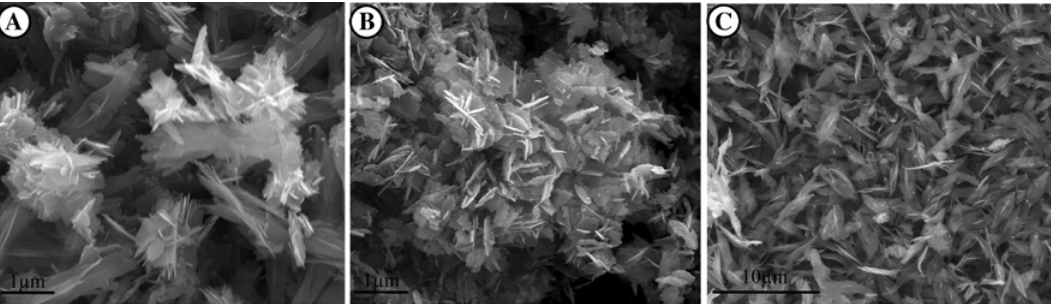
Figure 1: SEM image of (A) CuO-ZnO nanocomposite, (B) Zn oxide nanoparticles, (C) Cu oxide nanoparticles. Copyrights reserved to the Material Science Forum [37].